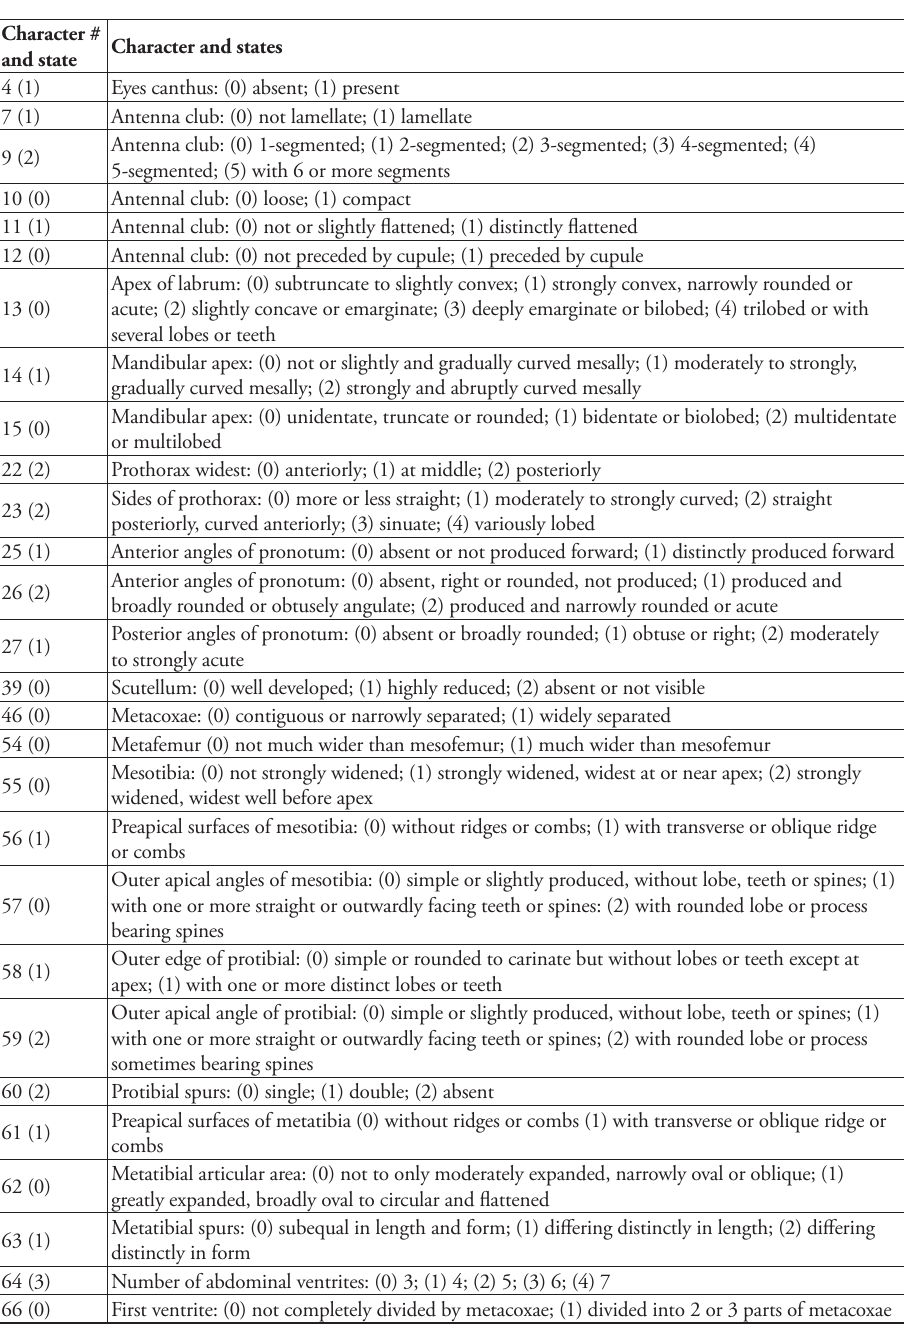
Table 1. List of 27 characters identified in the Orapa fossil for phylogenetic analysis (Fig. 3). The full characters set of 68 characters is given in Bai et al. (2011). Character numbers in the left column refer to the full character set. Characters state for the specimen is given in parentheses in the left